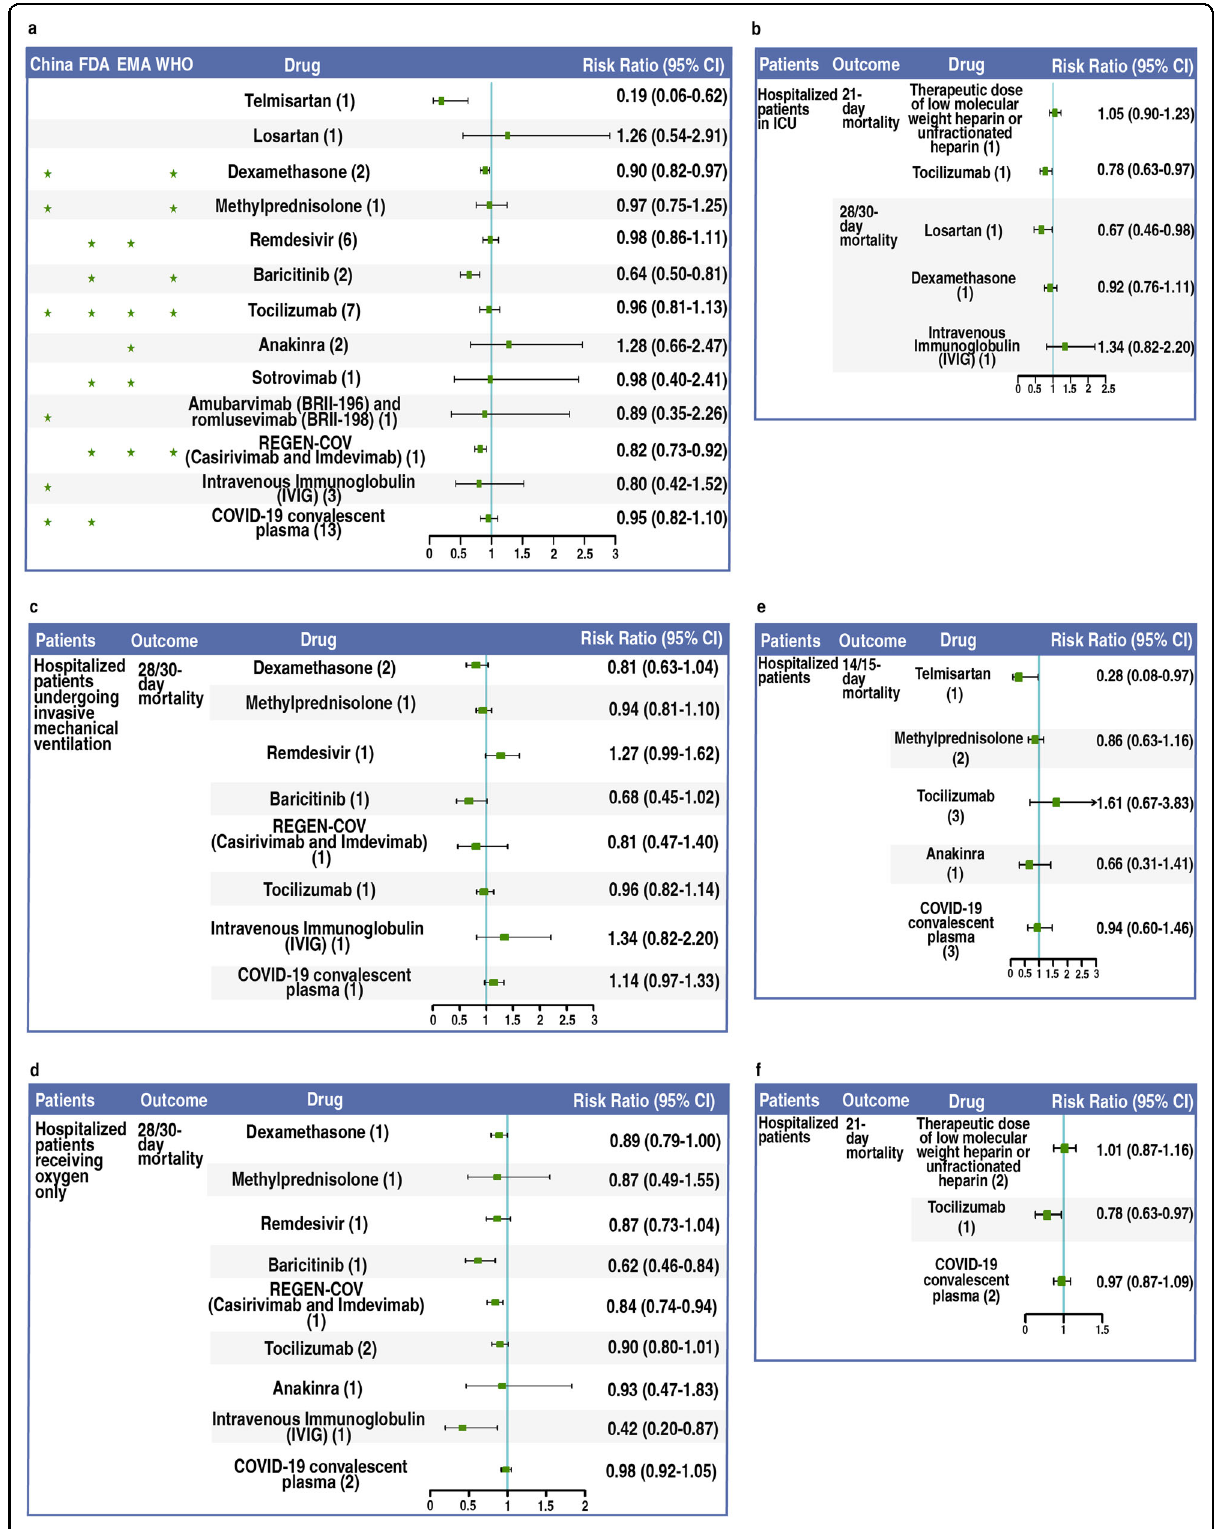
Fig. 1 Outcome and ef fi cacy of drugs in hospitalized patients with COVID-19. a Outcome (28/30-day mortality) and ef fi cacy of telmisartan, losartan, and 11 drugs recommended by China, FDA, EMA and WHO. b Outcome (21/28/30-day mortality) and ef fi cacy of drugs in hospitalized patients admitted to ICU. c Outcome (28/30-day mortality) and ef fi cacy of drugs in hospitalized patients undergoing invasive mechanical ventilation. d Outcome (28/30-day mortality) and ef fi cacy of drugs in hospitalized patients receiving oxygen only. e Outcome (14/15-day mortality) and ef fi cacy of drugs in hospitalized patients. f Outcome (21-day mortality) and ef fi cacy of drugs in hospitalized